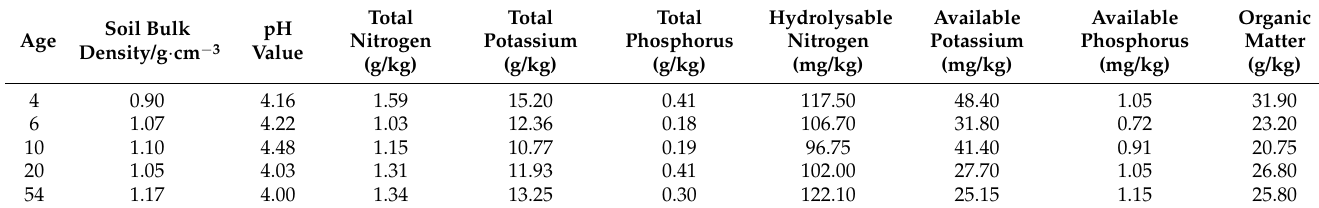
Table 2. Soil physical and chemical properties of differently aged samples of S. superba